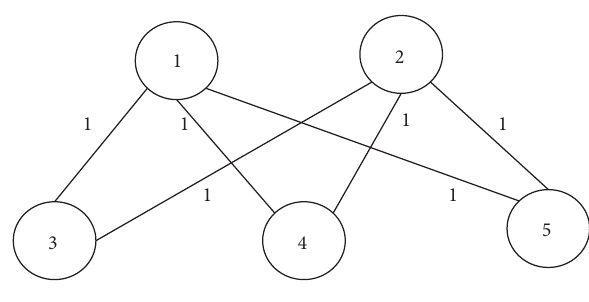
Figure 1: Topology of the multiagent networks